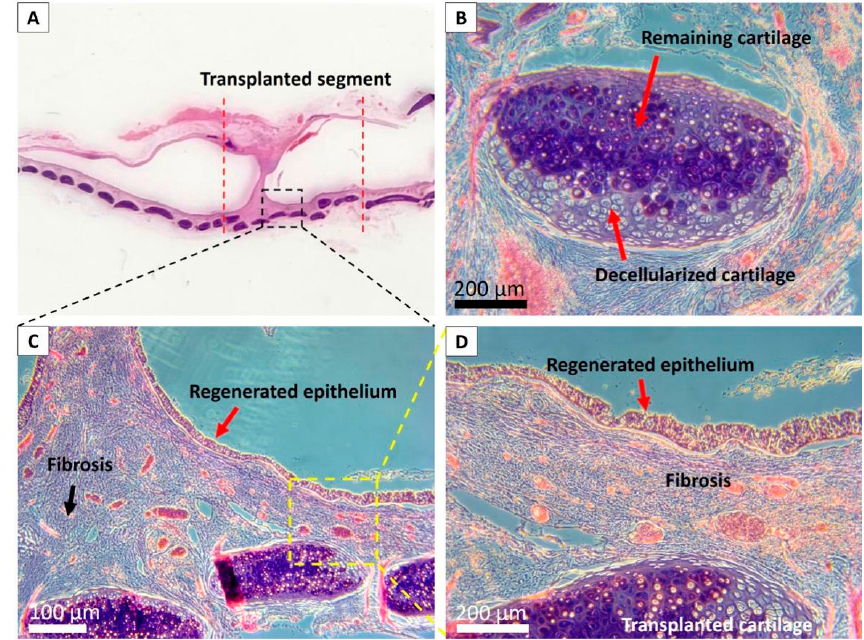
Figure 8. Histological evaluation of the tracheal allograft segment in the rabbit two years post- transplantation. ( A ): Microscopic observation of explanted trachea two years posttransplantation; ( B ): Remained cartilage in the transplanted scaffold; ( C ): The fibrosis had a tendency to develop at the central luminal aspect of the transplanted graft and protruded into the tracheal lumen, forming a circular stenosis ring; ( D ): Complete regenerated epithelium can be observed at the non-stenotic luminal